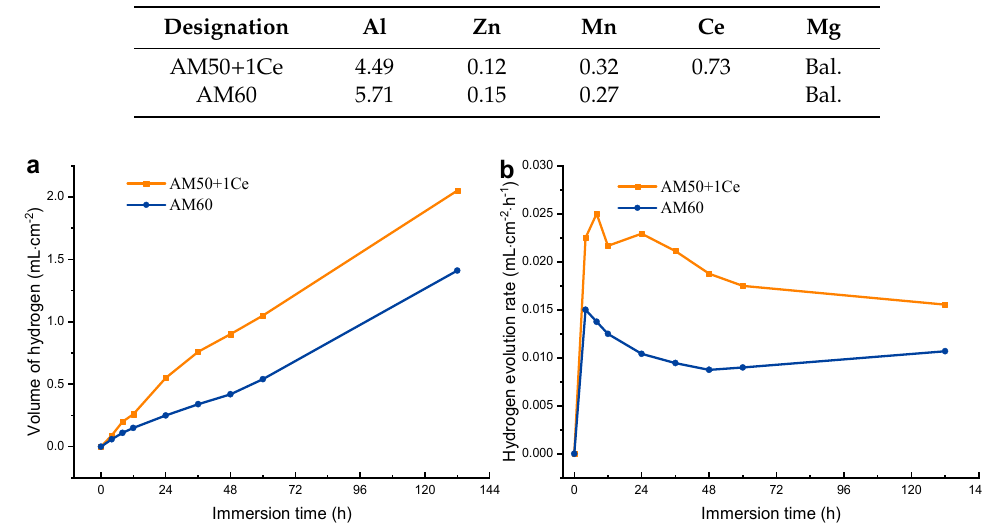
Figure 4. ( a ) XRD pattern and ( b ) SEM with EDS of higher pressure die casting (HPDC) AM50+1Ce and AM60 magnesium alloys. Table 1. Actual composition of the tested alloys.